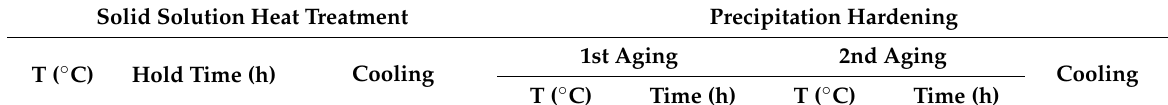
Table 2. Heat treatment scheme of the investigated